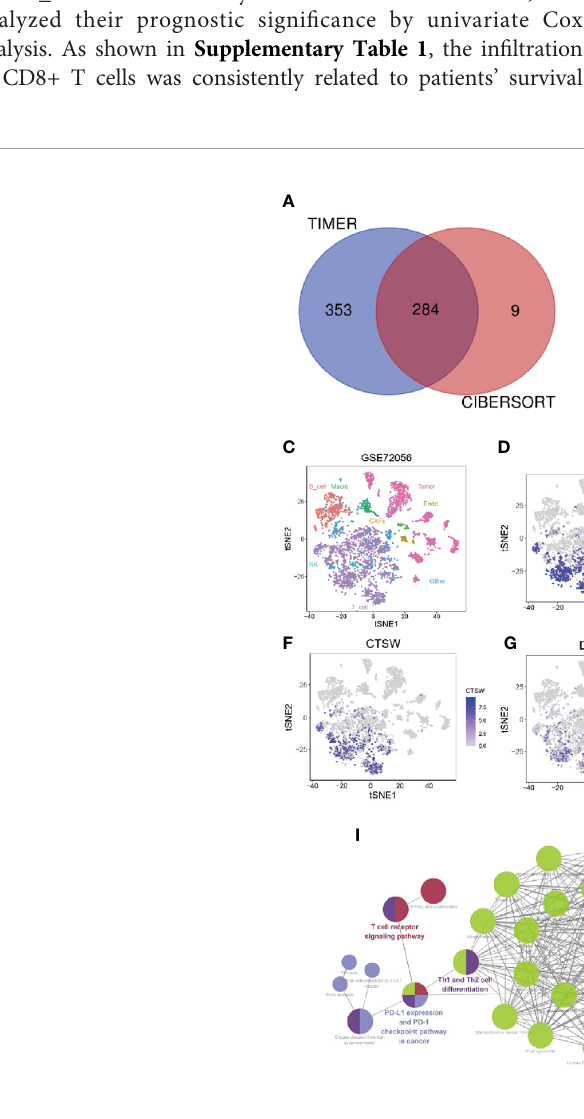
FIGURE 1 | Identi fi cation and enrichment analysis of TIRGs in melanoma cells. (A) Venn diagram to identify TIRGs in melanoma patients from the TCGA dataset by using TIMER and CYBERSORT. (B) Venn diagram to screen TIRGs in melanoma patients from datasets TGCA, GSE65094 and GSE19234. (C) t-SNE analysis of single cell sequencing dataset GSE72056 illustrates gene expression patterns in different cell types (shown in different colors). (D, E) The expression pattern of CD8A (D) and CD8B (E) indicates the distribution of CD8+ T cells. (F – H) Illustration of three excluded TIRGs that were highly expressed in more than 50% of CD8+ T cells but less than 10% of the remaining cells in TME: CTSW (F) , DTHD1 (G) and LAG3 (H) . (I) KEGG enrichment analysis of the candidate TIRGs in melanoma